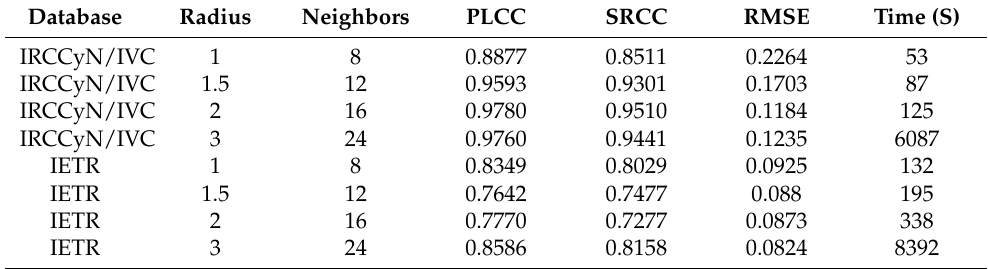
Table 1. Performance comparison of our designed algorithm with different LBP parameter